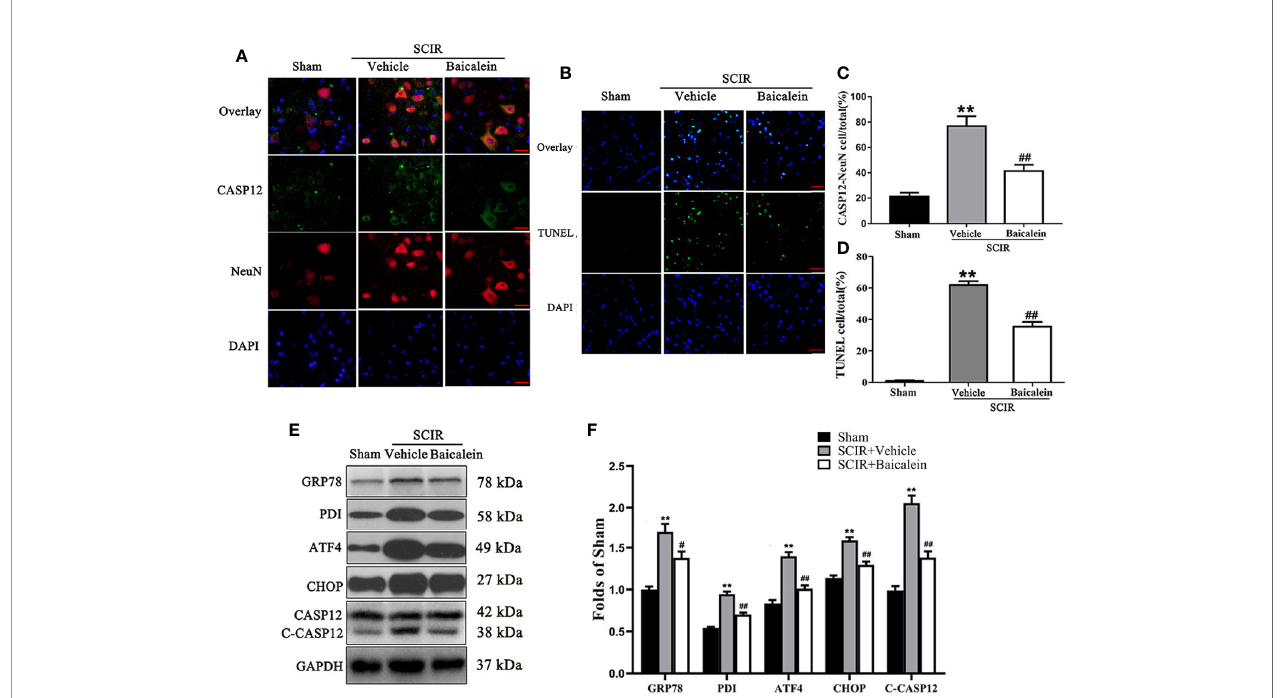
FIGURE 3 | Baicalein inhibits endoplasmic reticulum (ER) stress after spinal cord ischemia-reperfusion injury (SCIR). (A) Immuno fl uorescence staining for CASP12 and NeuN colocalization in the spinal cords of the Sham, SCIR+Vehicle, and SCIR+Baicalein groups (Scan bar= 25 m m). (B) Transferase dUTP nick end labeling (TUNEL) staining for labeling apoptotic cells at the spinal cord lesion after SCIR. (C) The quantitative percentage of the CASP12-positive neurons in the Sham, SCIR+Vehicle, and SCIR+Baicalein groups. (D) The quantitative percentage of the TUNEL-positive cells at the spinal cord lesion in each group. (E) Western blotting for GRP78, PDI, ATF4, CHOP, and CASP12 expression levels in the Sham, SCIR+Vehicle, and SCIR+Baicalein groups. The gels were run under the same experimental conditions, and the cropped blots are shown here. (F) The optical density values of the GRP78, PDI, ATF4, CHOP, and CASP12 expression levels were quanti fi ed and analyzed in each group. The values are expressed as the means ± SEM, n=5 per group. ** p < 0.01, vs. Sham group. # p < 0.05 and ## p < 0.01, vs. SCIR+Vehicle